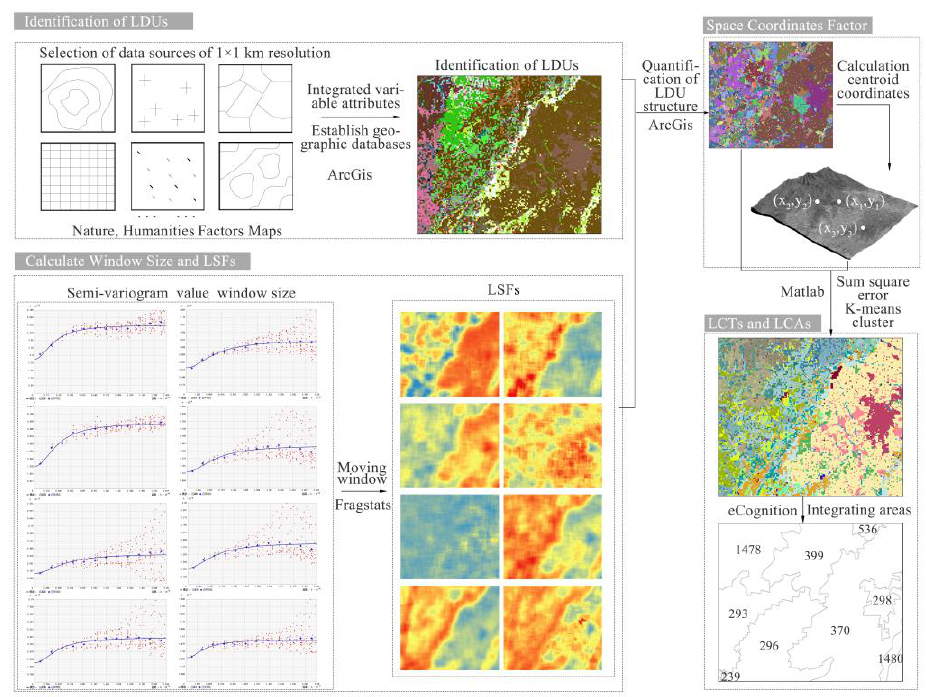
Figure 1. Flowchart depicting the process used to determine China’s terrestrial landscape character types and identify landscape character areas.